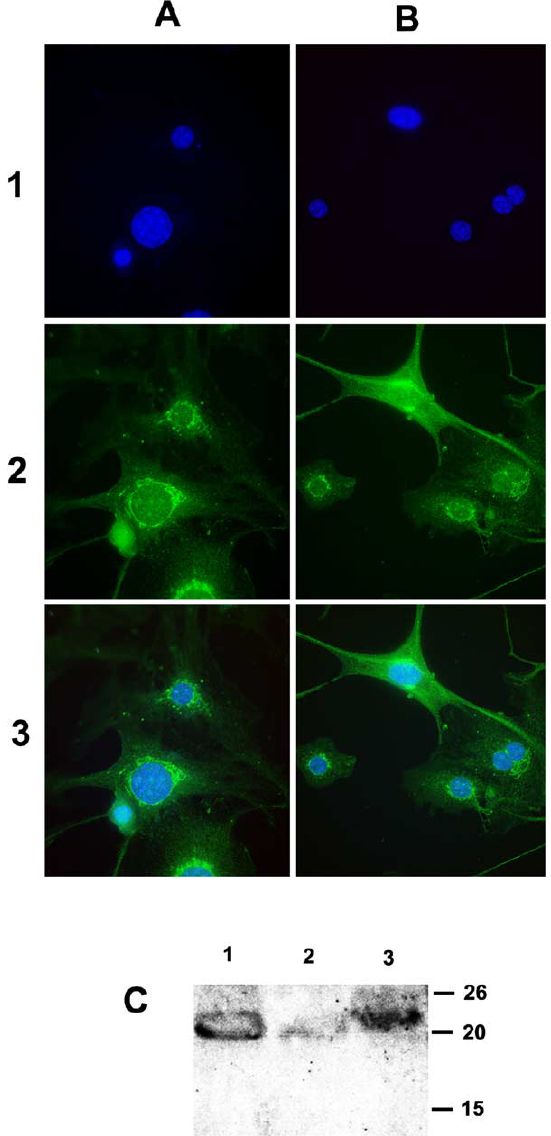
Fig. 1. Analysis of stable NIH 3T3 clones expressing HCV core af- ter 100 passages. Immunofluorescence staining of NIH191-3 (panel A); and NIH191-10 (panel B), clones. Fields 1–2 in each of the pan- els visualize one area recorded after excitation with ultraviolet light for nuclear staining (field 1); with 488 nm light for FITC staining (field 2); overlay of fields 1 and 2 (field 3). Panel C illustrates West- ern blotting of stable clones NIH191-10 (lane 1), NIH191-3 (lane 2), and NIH 3T3 transiently transfected with the plasmid expressing full-length HCV core pCMVcore191 (lane 3). On the right are posi- tions of 14.9, 19.6 and 26 kDa molecular mass